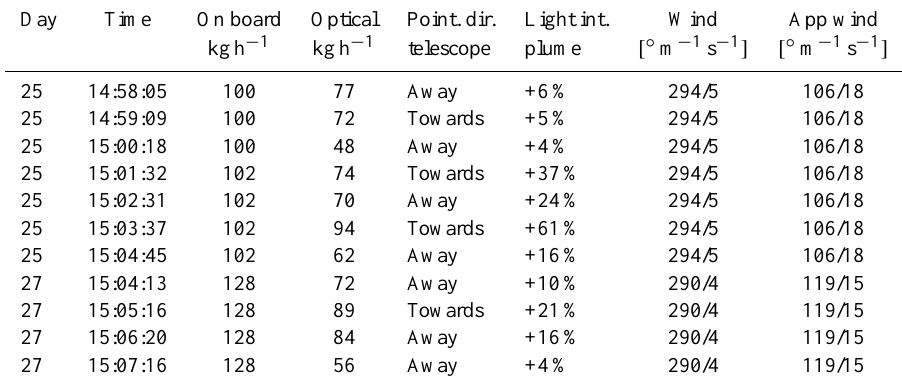
Table 4. Optical SO 2 measurements of ship emission rates performed on the North Sea. The data corresponds to 3 days between 24 and 27 September 2009. The acronyms in the header correspond to IMO number of ship, Dead Weight Ton (DWT), ship speed in knots ( v ), mean SO 2 emission ( E ) in kgh − 1 and 1- σ emission variability (STD) in %. Day Time On board Optical Point. dir. Light int. Wind App wind telescope plume